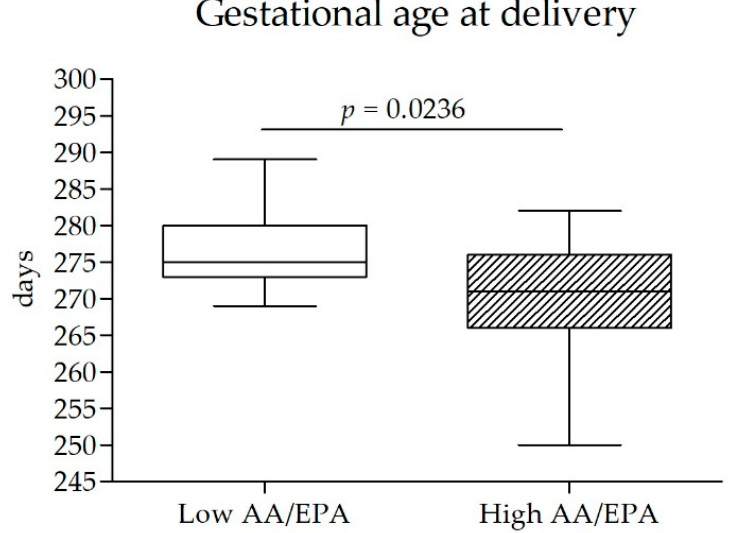
Figure 5. Comparison of the gestational age at delivery between subjects within the lower quartile of AA/EPA ratio in red blood cells at enrollment ( n = 13; AA/EPA < 28.7; Low AA/EPA) and subjects within the higher AA/EPA ratio quartile ( n = 13; AA/EPA > 55.2; High AA/EPA). AA/EPA— arachidonic acid/eicosapentaenoic acid ratio. Table 2. Age and anthropometric parameters at T0 of subjects with GD who required therapy to normalize blood glucose levels (GD+PT) and subjects who did not require pharmacological intervention (GD).